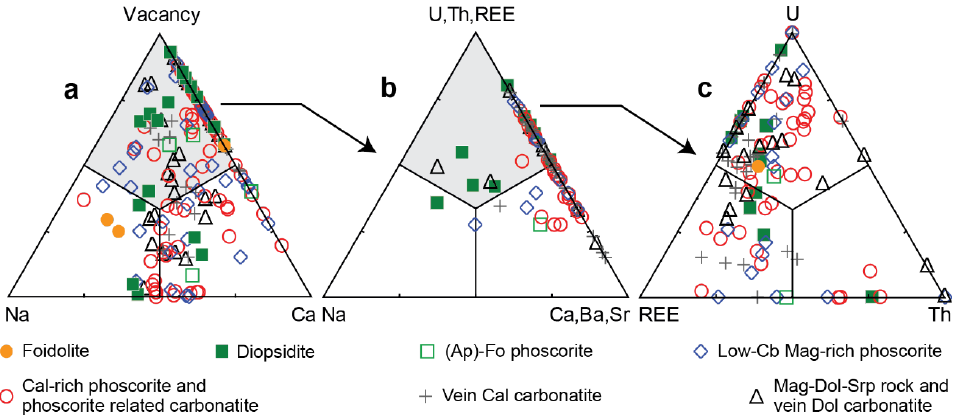
Figure 6. Relations between cations and vacancies in the A -site of the Kovdor PSM ( a —all samples, b —kenopyrochlores, c —kenopyrochlores enriched in high-charge cations).